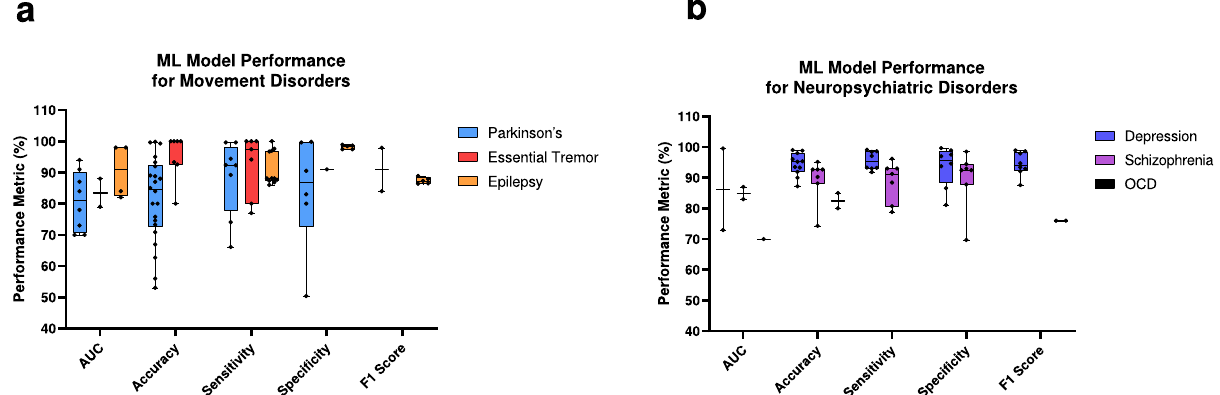
Fig. 1 Aggregated ML model performance. a ML model performance metrics were reported across 39 unique papers assessing ML in closed- loop systems for movement disorders. The models generally exceed 80% across performance metrics. Signi fi cant variation in model performance exists even for historically well-studied diseases such as Parkinson ’ s. More data is needed for essential tremors. b ML model performance metrics reported across 17 unique papers assessing ML in closed-loop systems for neuropsychiatric disorders. The median performance for depression and schizophrenia generally exceeds 90%. There is a lack of data on OCD. All data is shown as median (center line) and fi rst and third quartiles, with bars representing minimum and